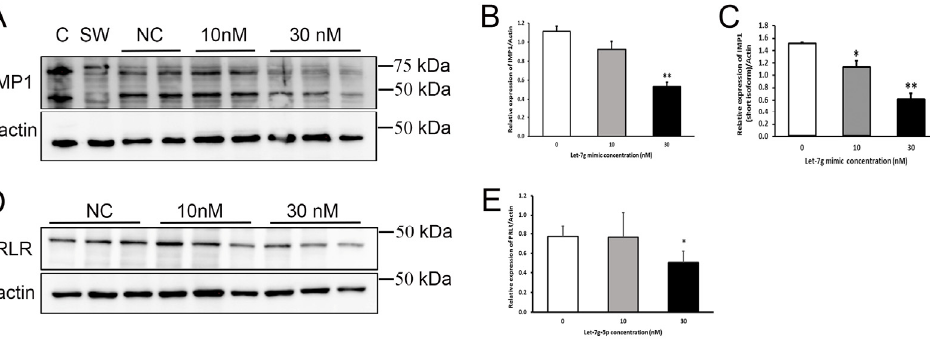
Figure 5. Let-7g-5p reduced IGF2BP1/IMP1 and prolactin receptor (PRLR) expression in mammary epithelial (HC11) cells. ( A ) Representative immunoblot of IGF2BP1/IMP1 in protein lysates (20 μ g protein/well) from HC11 cells transfected with 10 nM or 30 nM of let-7g-5p mimic compared with non-transfected (NC) cells. Caco-2 ( C ) and SW480 (SW) protein lysates were used as positive controls. Membranes were striped and re-probed for β -actin. ( B ) Relative expression of the long form of IGF2BP1/IMP1 (~70 kDa) after normalization to β -actin. Results represent the mean ratio ± SD ( n = 2–3 samples/group). ** p < 0.01 ( C ) Relative expression of the short form of IGF2BP1/IMP1 (~42 kDa) after normalization to β -actin. Results represent the mean ratio ± SD ( n = 2–3 samples/group). * p < 0.05, ** p < 0.01 ( D ) Representative immunoblot of PRLR in protein lysates (20 µ g protein/well) from HC11 cells transfected with 10 nM or 30 nM of let-7g-5p mimic compared with non-transfected (NC € ells. ( E ) Relative PRLR protein expression of after normaliza- tion to β -actin. Results represent the mean ratio ± SD ( n = 3 samples/group) from two separate experiments. * p <